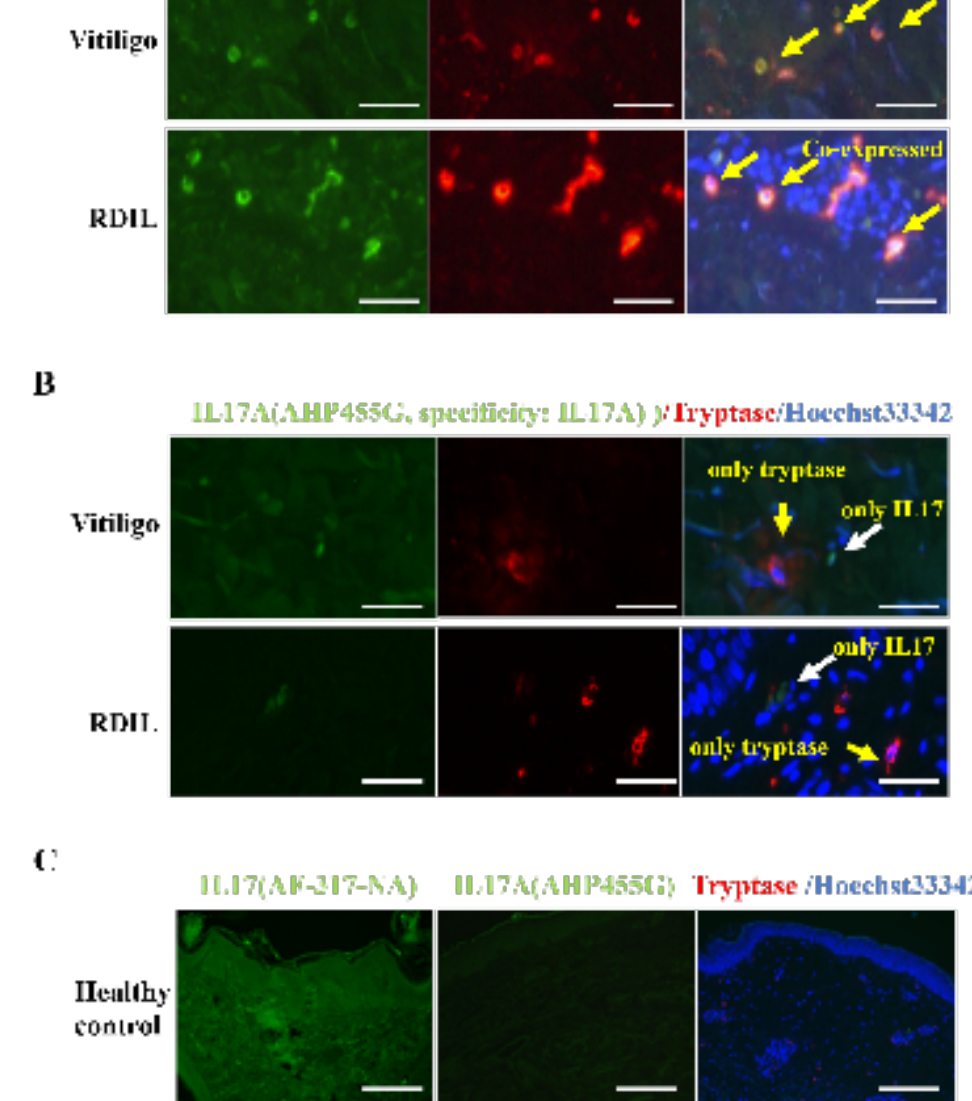
Figure 1. A polyclonal, but not monoclonal, anti-IL17 antibody dose stains tryptase-positive mast cells. Skin sections from vitiligo and RDIL were stained with anti-IL17 polyclonal antibody (AF-317-NA; specificity: IL17A, B, D, F) (A) and the monoclonal anti IL17A (AHP455G; specificity: IL17A (B) in green, mast cells were stained with anti-tryptase in red, cell nuclei were stained in blue with Hoechst33342. Consecutive skin sections from healthy control were stained with polyclonal IL17, monoclonal IL17A and tryptase antibodies (C). Scale bar: 100